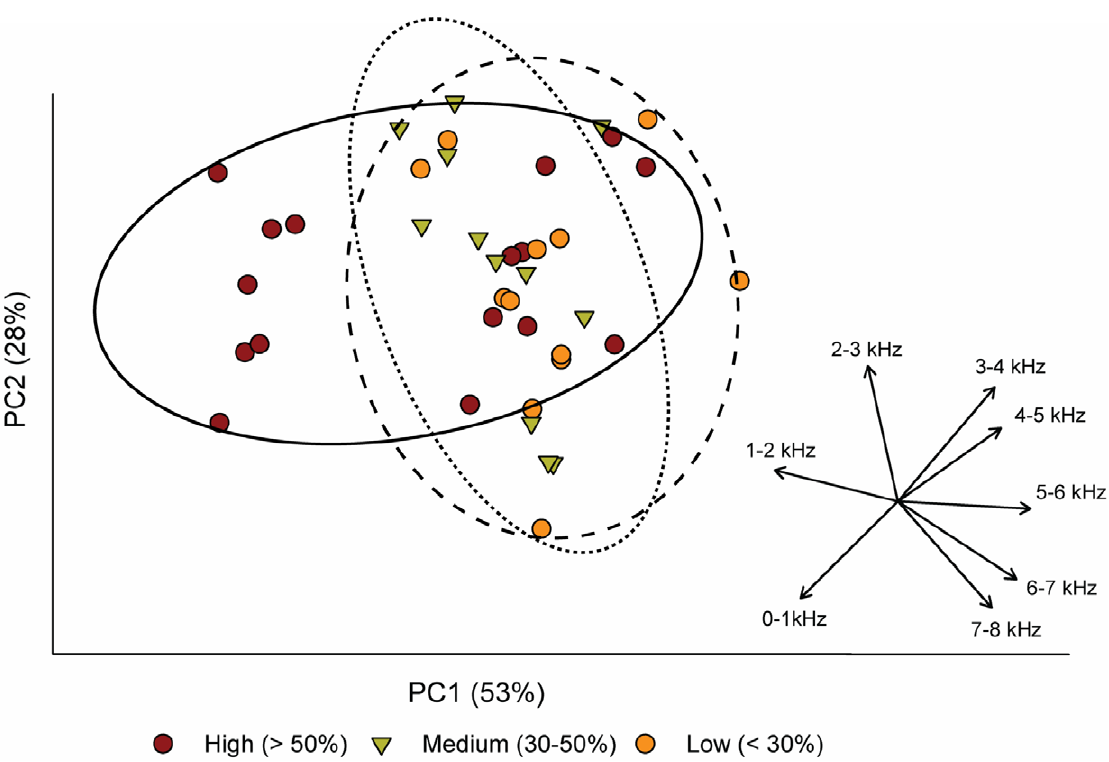
Figure 4. Dominant frequencies and acoustic variation by urban category in multivariate space. Principal component analysis summarizing patterns of relative power in eight frequency intervals across the study lakes. Each data point represents one of four time periods at an individual lake. Urban categories are delineated with ordination hulls (90% confidence interval) according to High (solid), Medium (dotted), and Low (dashed) surrounding urbanization. Inset displays the component loadings (eigenvectors) for each frequency interval.